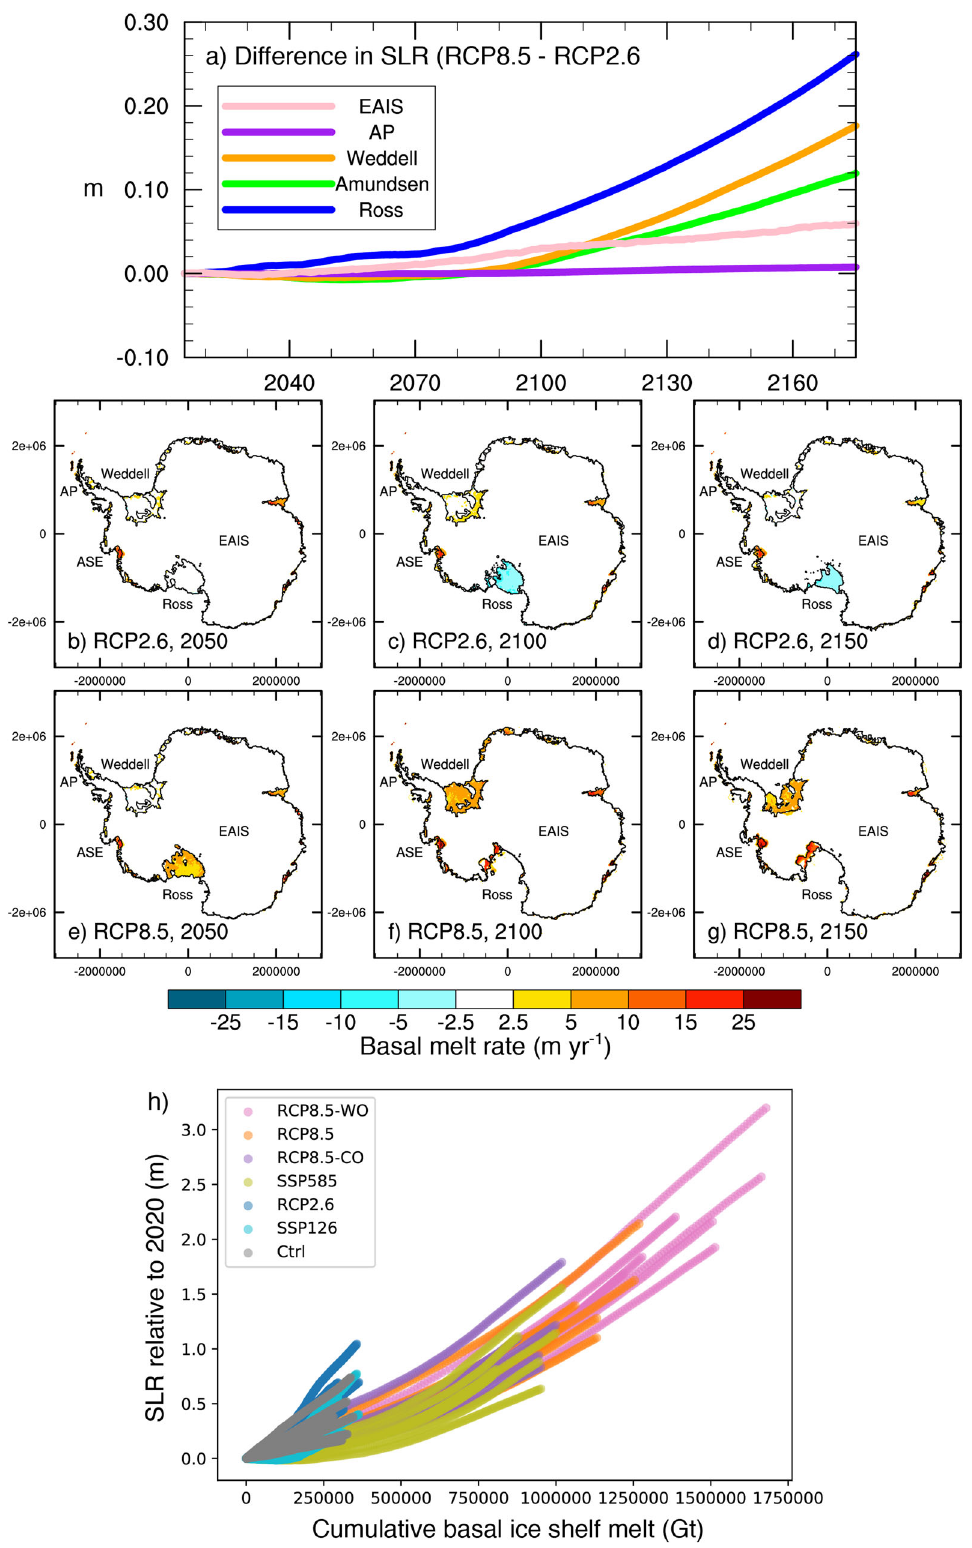
Fig. 6 Scenario differences by AIS sector and sensitivity to basal melt rates. a Difference in ensemble average sea-level contribution (RCP8.5 – RCP2.6) by AIS sector. We use the same sector boundaries as de fi ned in Levermann et al. (2020) 75 . Decadally averaged basal melt rate in 50-year increments for b – d the RCP2.6 ensemble average and e – g the RCP8.5 ensemble average. h Sea-level contribution (m) relative to 2020 versus cumulative basal melt (Gt yr − 1 ) in the historically constrained ice sheet simulations for the same time period as panel a , with color indicating the climate forcing scenario.